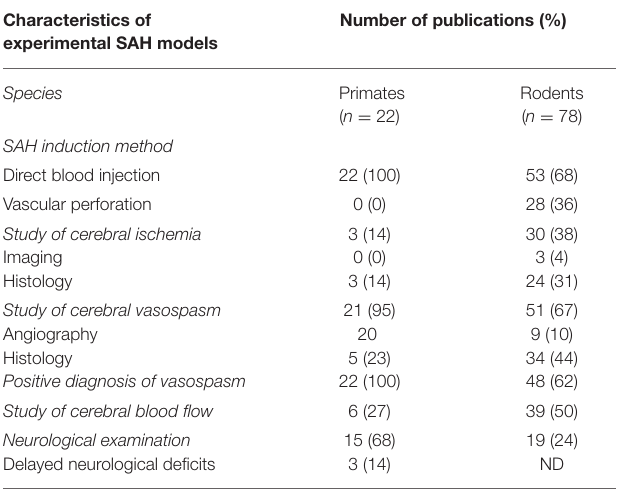
TABLE 2 | Comparison between primates and rodents SAH models focusing on main